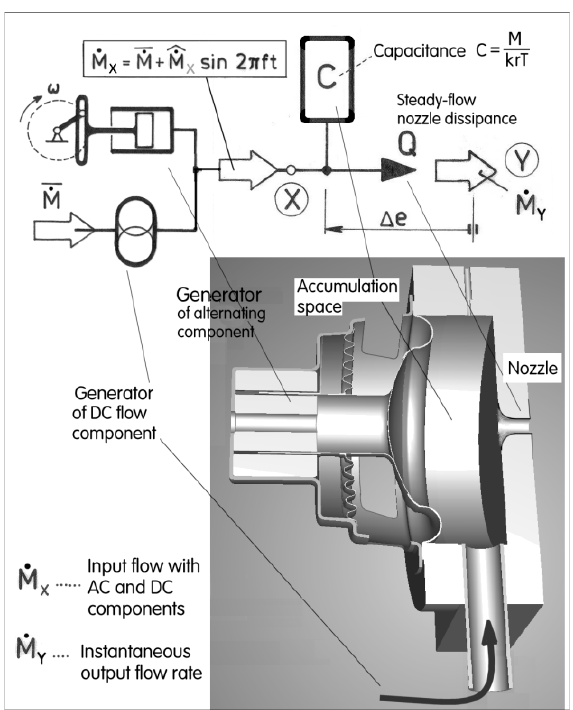
An example and schematic representation of the test configurations used for investigating the effect of attached accumulation chamber. Instead of the original piston-type devices, with inertial-limited frequency range, these later devices used loudspeaker driver generating the AC flow component.